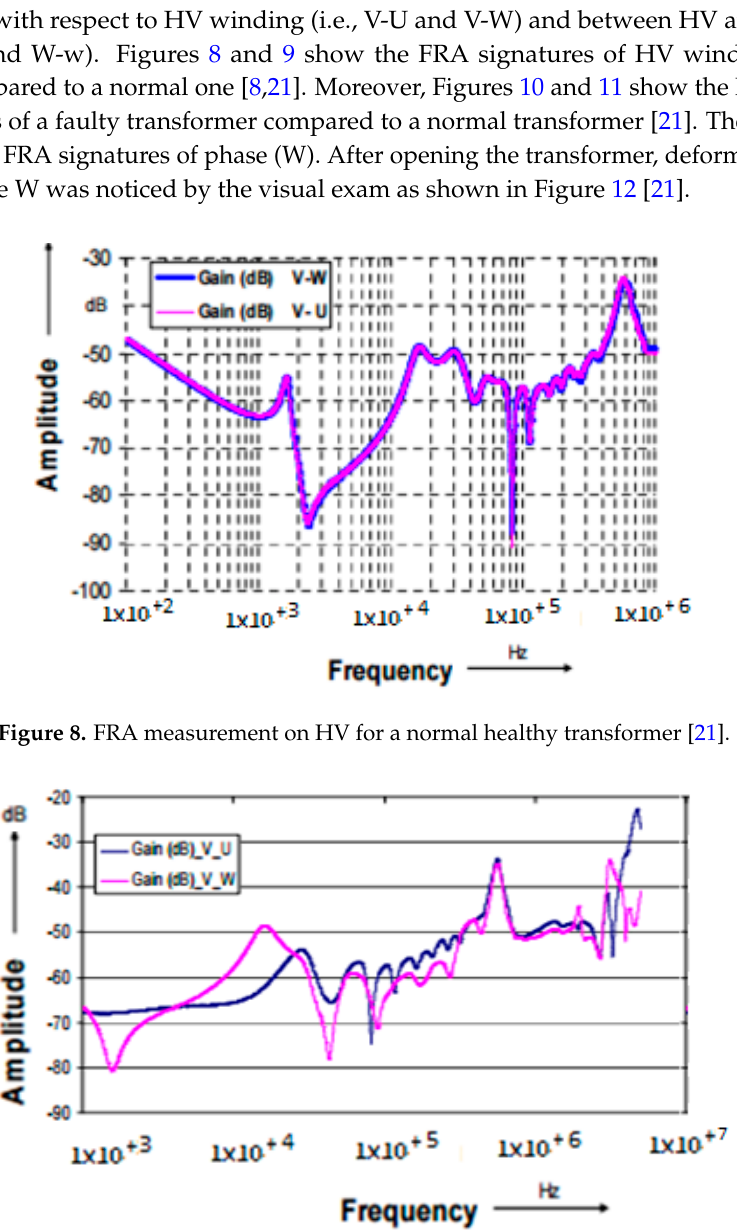
Figure 9. FRA measurement on HV winding for a faulty transformer [21].